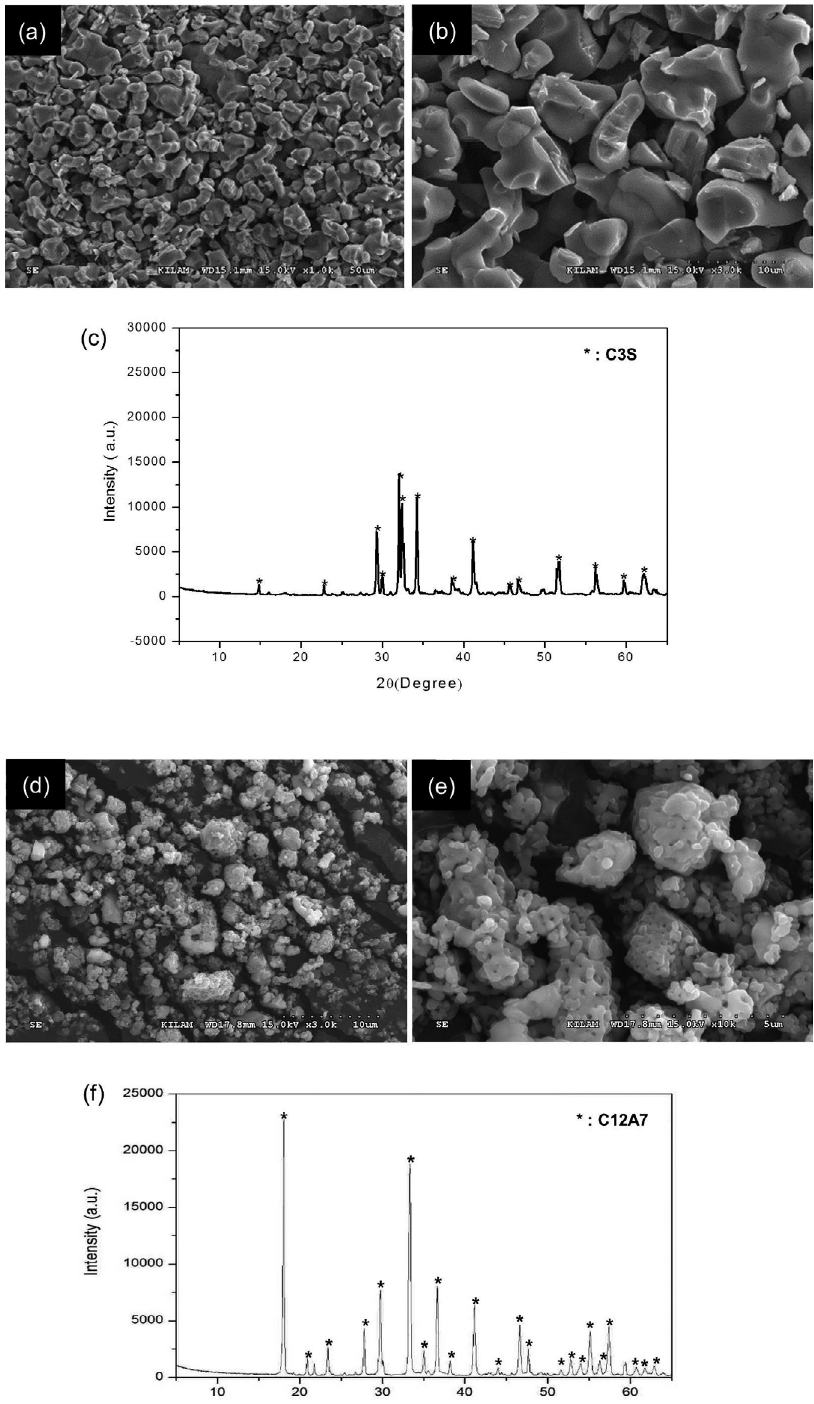
Figure 1- Characterization of prepared C3S and C12A7 powder; (A-B) Scanning electron microscope (SEM) images (x1000 and x3000, respectively) showed homogeneous compositions of particles in the C3S cement; (C) X-ray diffraction (XRD) characteristics of fabricated cement confirmed the powder as the C3S showing precisely identical peaks with that; (D-E) SEM images (x3000 and x10000, respectively) showed the characterization of the surface of C12A7 powder. (f) Fabricated powder was confirmed as C12A7 showing the same